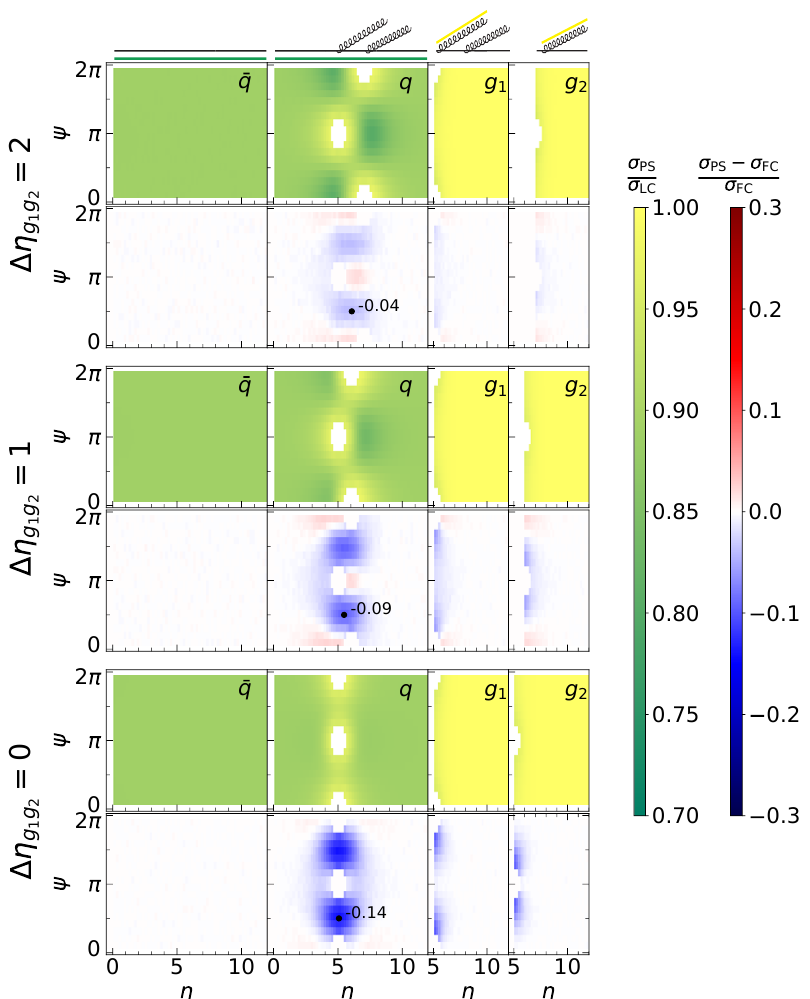
Figure 14. Results from the NODS scheme for the PanGlobal ( β = 0 ) shower, in an initial configuration ¯ qqg + g where the two gluons g and g are not strongly angular-ordered. We 1 g 2 1 2 show three configurations with the gluon g brought increasingly closer to g : for a fixed η = 5 , 2 1 g 1 = π , the second gluon g is placed at η = 7 (top), η = 6 (middle) and η = 5 (bottom) at ψ g 2 g 2 g 2 g 2 1 an azimuthal angle ψ = 0 . Black dots convey the largest negative deviation between the NODS g 2 scheme and the exact tree-level matrix